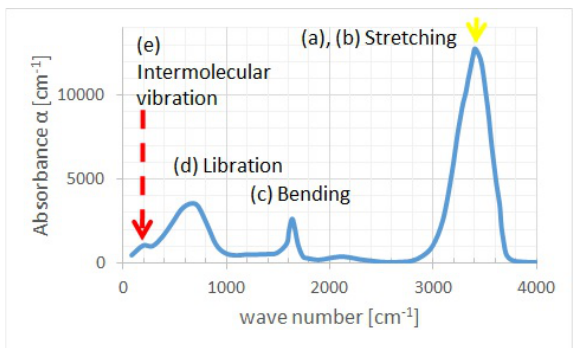
Figure 3. Absorption spectrum of water in the liquid phase [24]. Yellow and red broken lines represent the vibration modes (b) and (e),